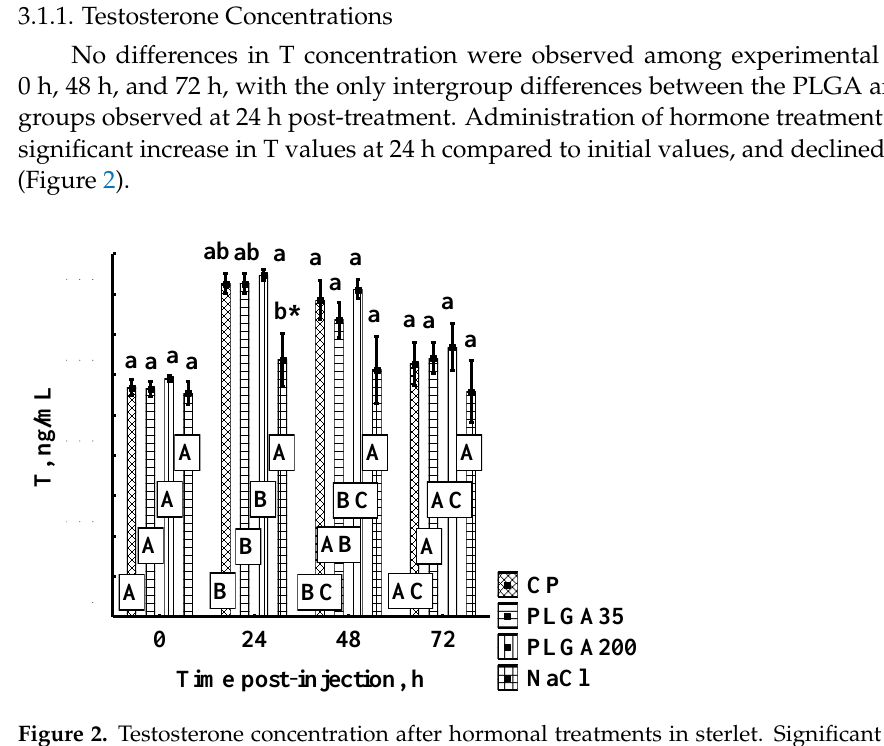
Figure 2. Testosterone concentration after hormonal treatments in sterlet. Significant differences among groups at a sampling point are indicated by lower case letters ( p < 0.05). Significant differences within an experimental group at a different post-injection time are indicated by upper case letters (multiple comparisons of mean ranks for all groups, p < 0.05). * — indicates a significant pairwise difference between treatment by NaCl (control, dose 1 mL (0.9%NaCl)/kg) and each experimental group at 24 h post-injection (Mann – Whitney U-test, p < 0.05). Experimental treatments: CP — carp pituitary extract, dose 4 mg/kg; PLGA35 — Alarelin, dose 35 µg/kg; PLGA200 — Alarelin, dose 200 µg/kg.